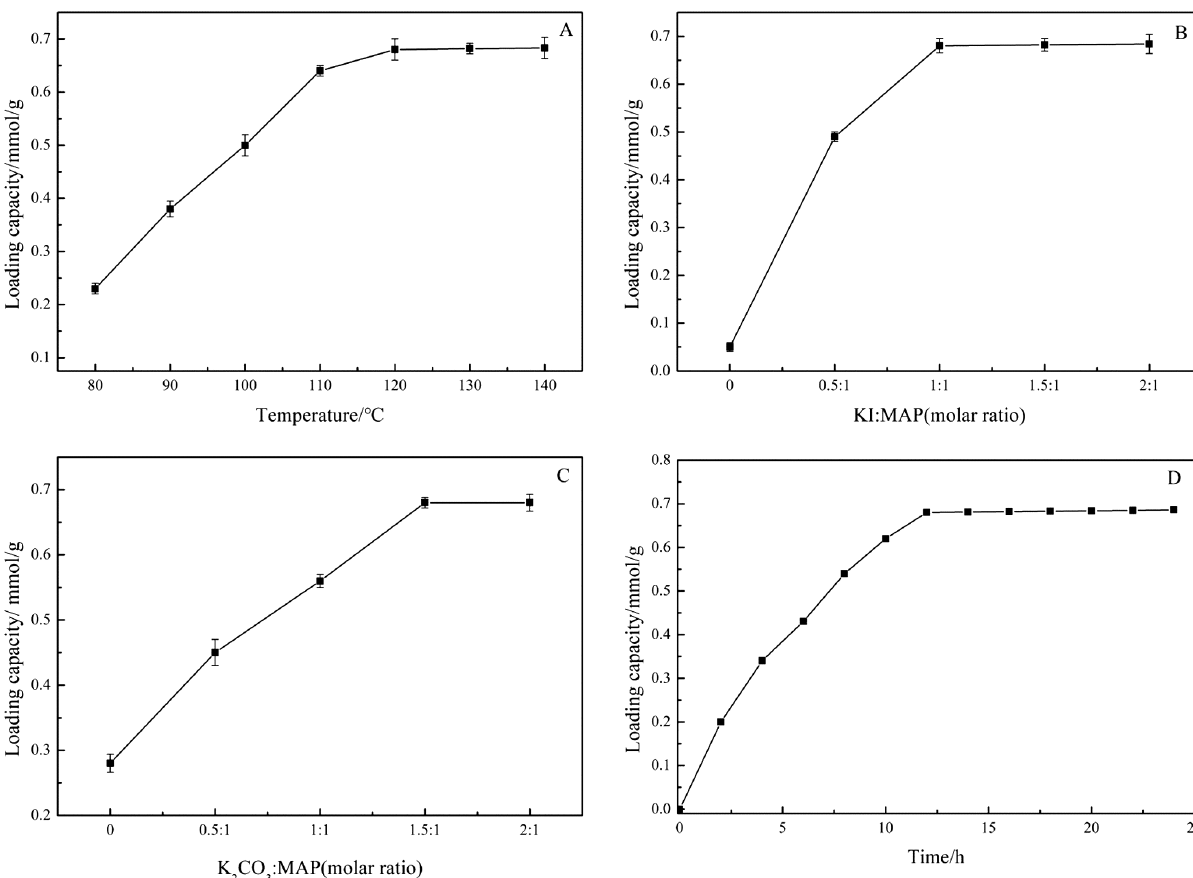
Figure 2: The optimal conditions of N-alkylation